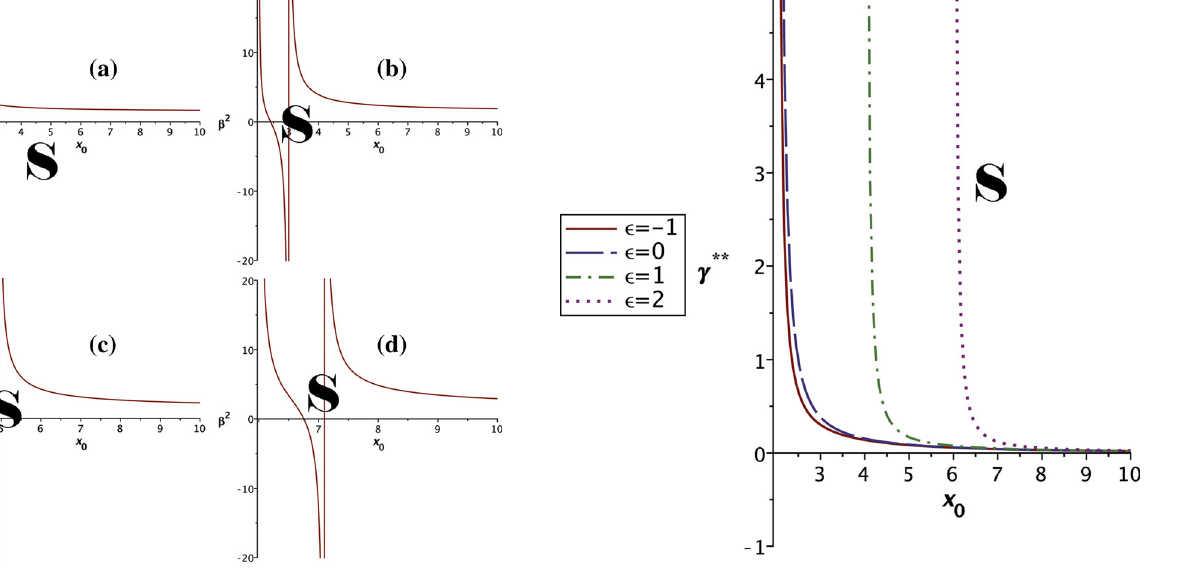
Fig. 8 γ ∗∗ against x 0 is plotted for an S–S ∗ ATSW when β 2 = 0, for four diverse values of (cid:18) . Again, (cid:18) = − 1 and (cid:18) = 0 are related to